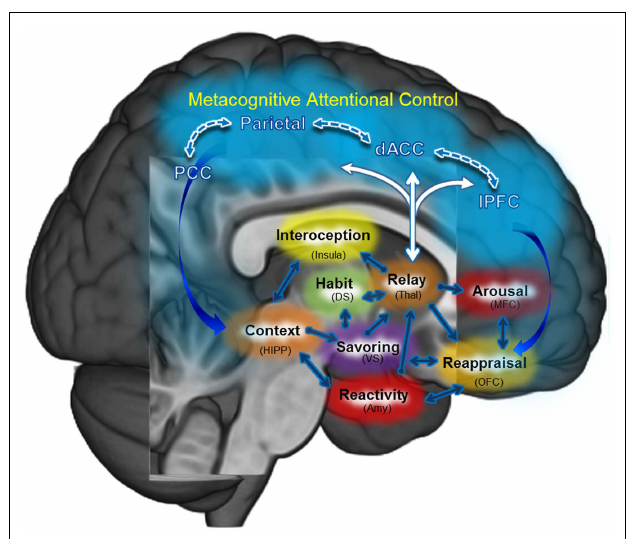
FIGURE 2 | Mindfulness-centered regulation: the central tenet of this model posits that mindfulness-based interventions (MBI’s) may remediate dysregulated habit behaviors, craving, and affect primarily by way of strengthening functional connectivity: (1) within a metacognitive attentional control network (PFC,ACC, Parietal); and (2) between that metacognitive attentional control network and the (a) habit circuit, (b) craving circuit, and (c) affect circuit